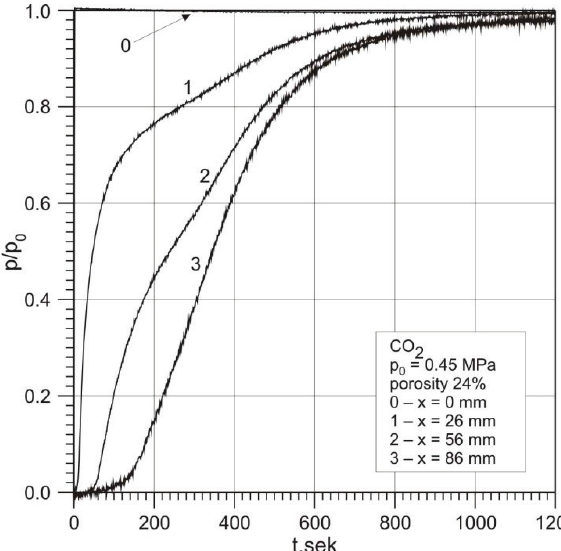
Figure 8: Saturation of the briquette with carbon dioxide - the bottom of the briquette is closed.